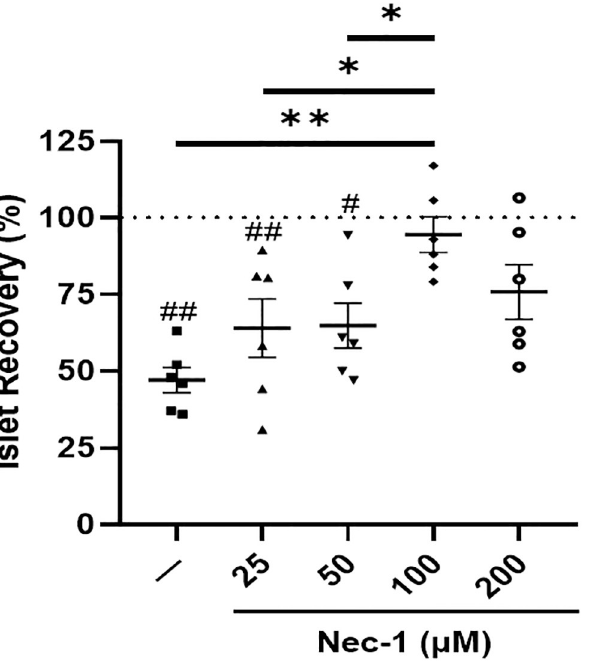
Fig 1. Islet recovery after 7 days of tissue culture in control media (—) or media supplemented with 4 different doses of necrostatin-1 (25, 50, 100, or 200 μ M of Nec-1) on day 3. Islet recovery was calculated by normalizing the islet equivalents of all groups on day 7 to day 3 before Nec-1 supplementation (dotted line) and expressed as percentage. n = 6 for each group. # p < .05 vs day 3. ## p < .01 vs day 3. � p < .05. �� p < .01. Data are expressed as mean ±